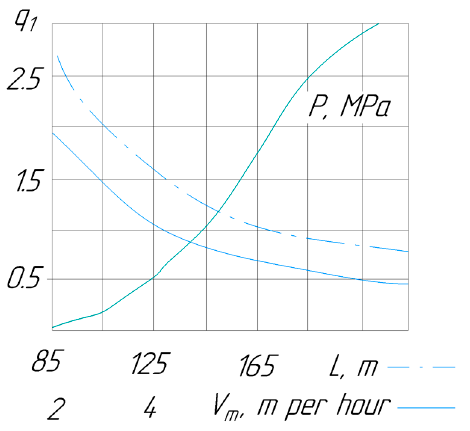
Figure 1. Dependence of criterion q 1 on well depth and correlation between rate of penetration and criterion q 1 ; V m —rate of penetration, P—weight on bit, L—drilling depth. criterion q 1 ; V m —rate of penetration, P—weight on bit, L—drilling